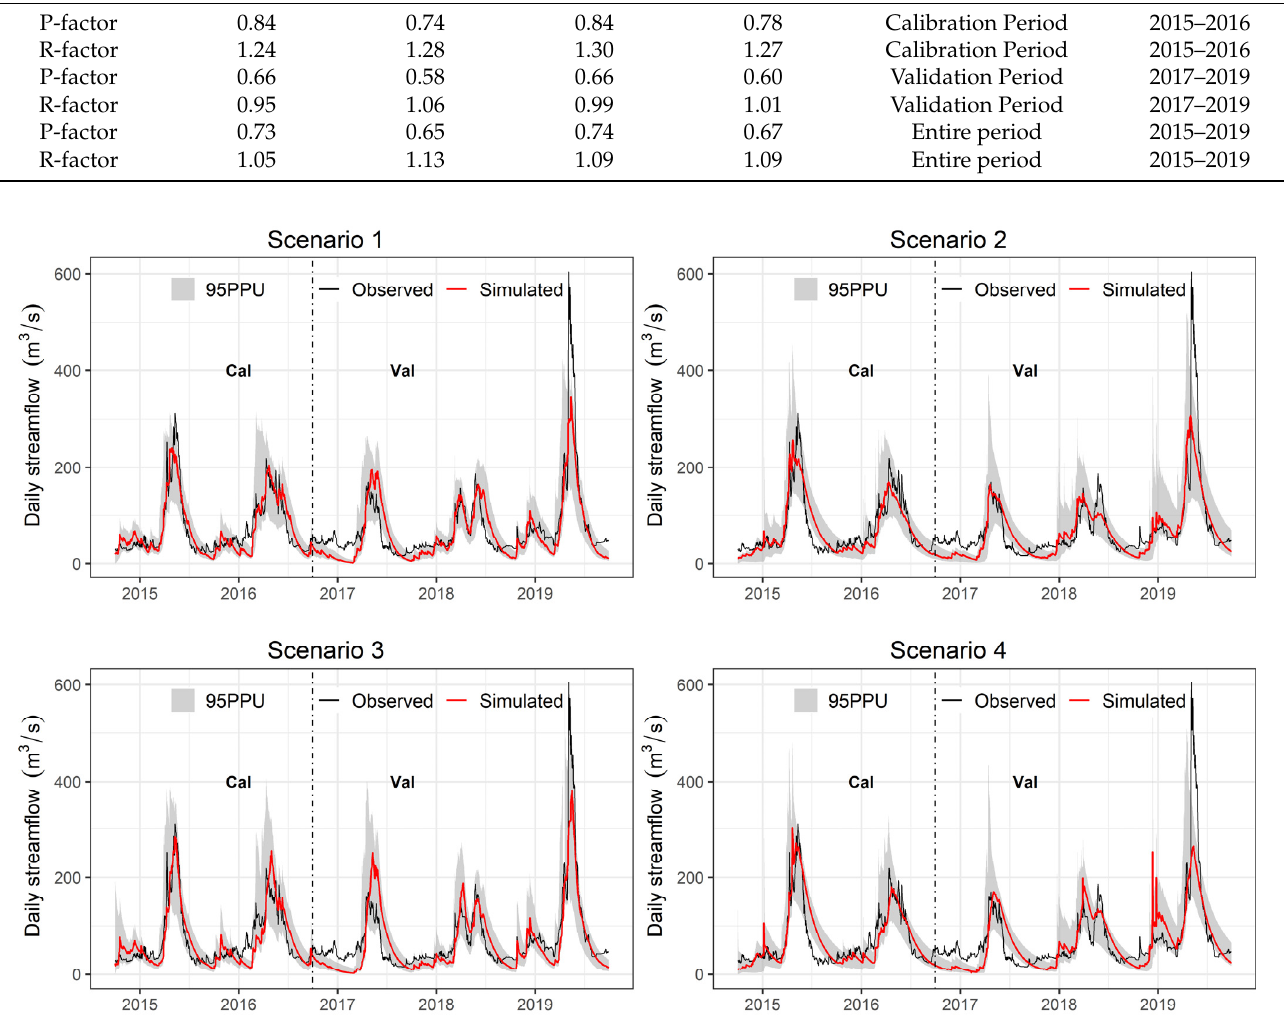
Figure 6. Observed and simulated discharge based on optimum model parameter value and